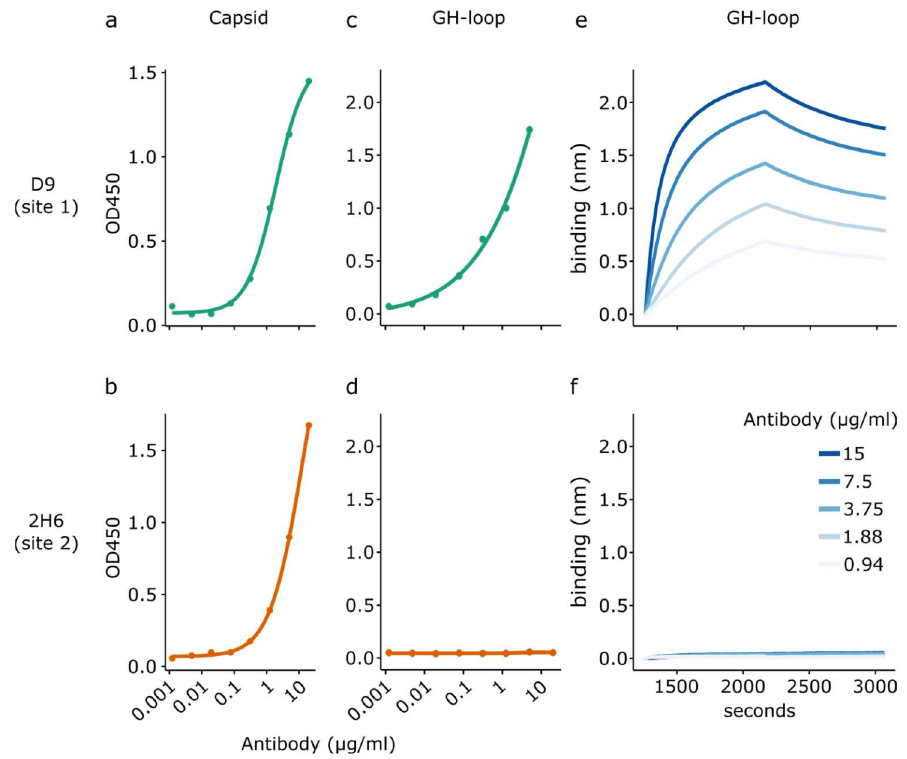
Figure 5. Measurement of specific interactions using a peptide surrogate of the GH loop. ELISA reactivity of the monoclonal antibodies D9 ( a ) and 2H6 ( b ) targeting antigenic sites 1 (GH loop) and 2, respectively, with complete recombinant capsids. ELISA reactivity of the monoclonal antibodies D9 ( c ) and 2H6 ( d ) targeting antigenic sites 1 (GH loop) and 2, respectively, with GH-loop peptides. BLI association and dissociation data for antibodies D9 and 2H6 when using the GH loop as a ligand ( e , f